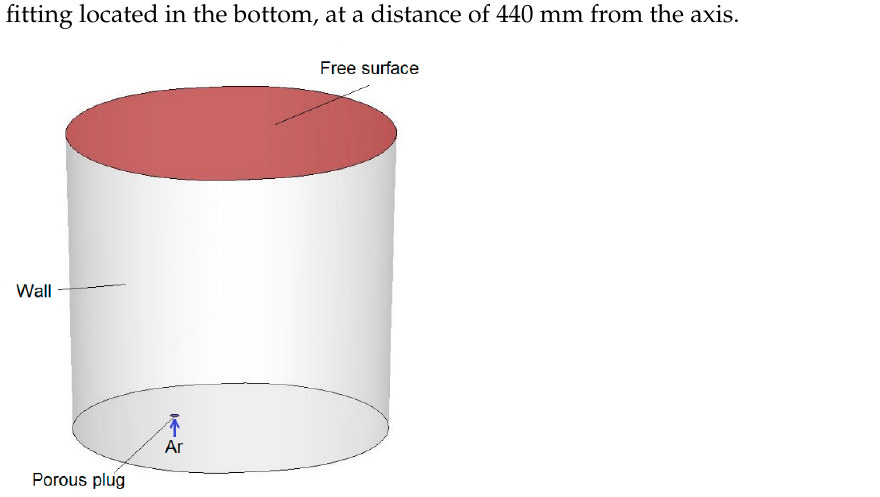
Figure 1. Schematic view of ladle with applied boundary conditions.